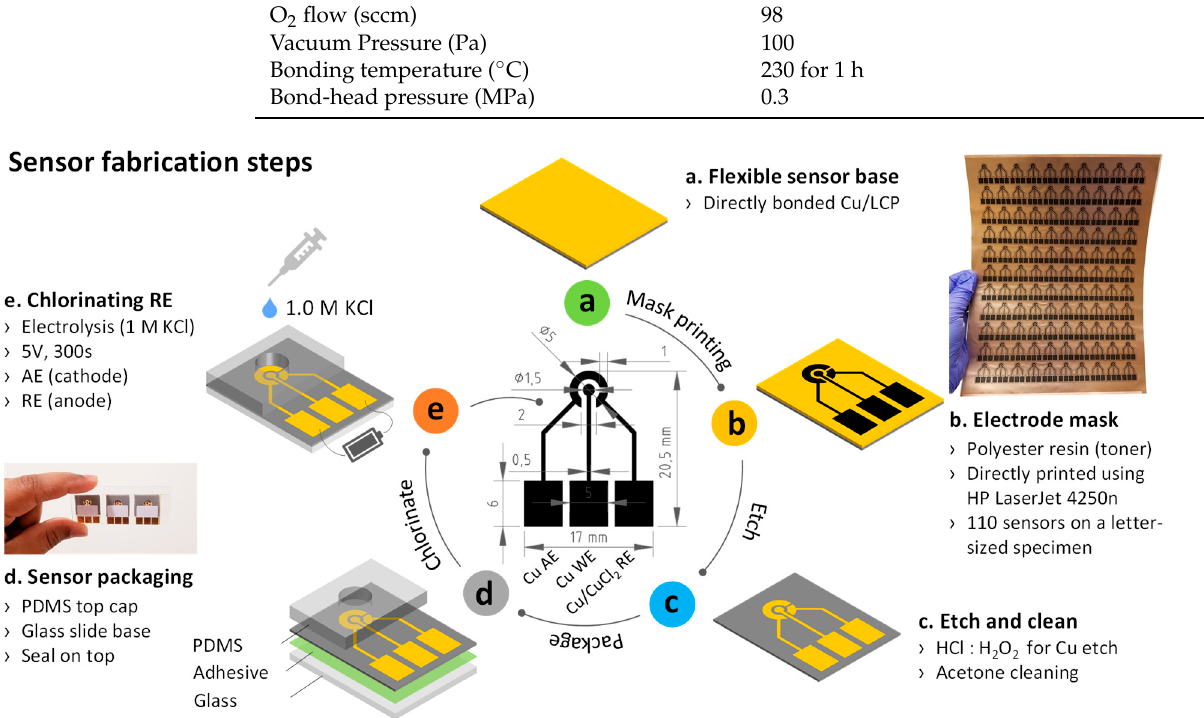
Figure 1. ( a – e ) Pb sensor fabrication steps. Inset illustrates the electrode size. A letter-sized flexible specimen can accommodate 10 × 11 sensors. SAB parameters used for direct bonding of Cu/LCP specimen are listed in Table 1. Table 1. Surface activated bonding (SAB) parameters for directly bonded electrodes.